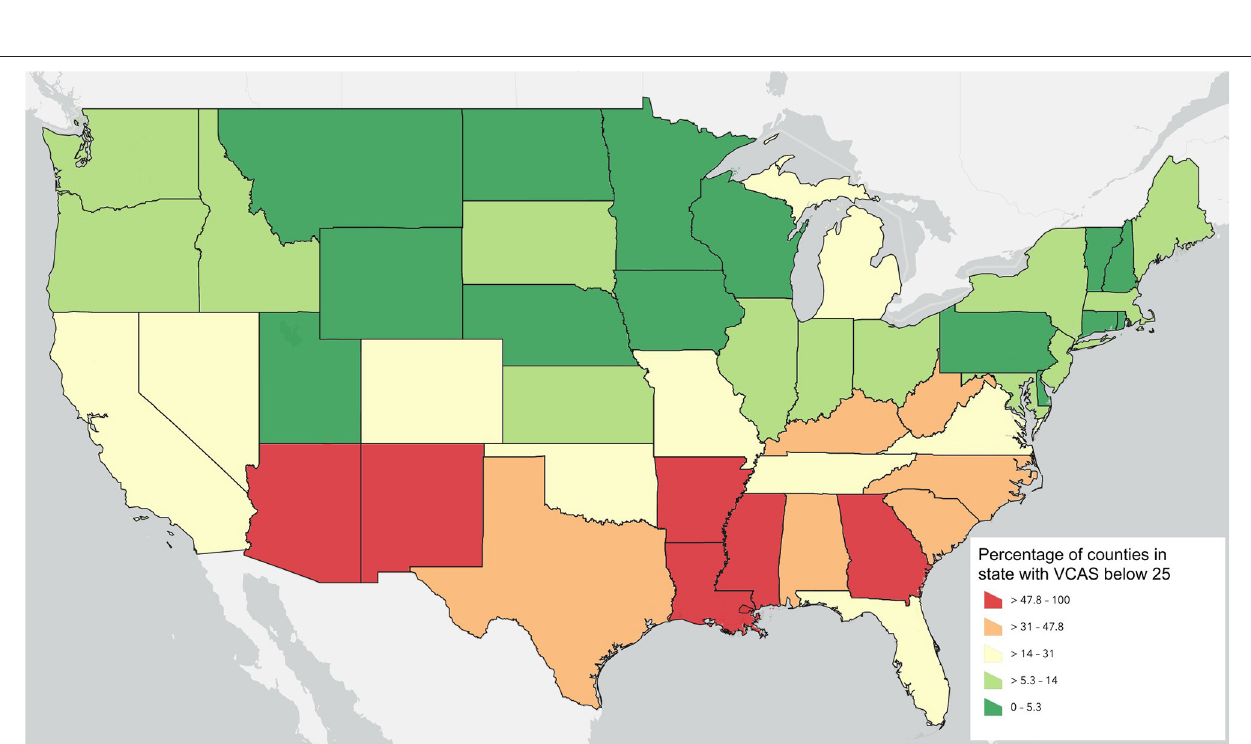
FIGURE 3 | Proportion of counties falling in the lowest quartile of the national VACS by symbolized by quintiles.